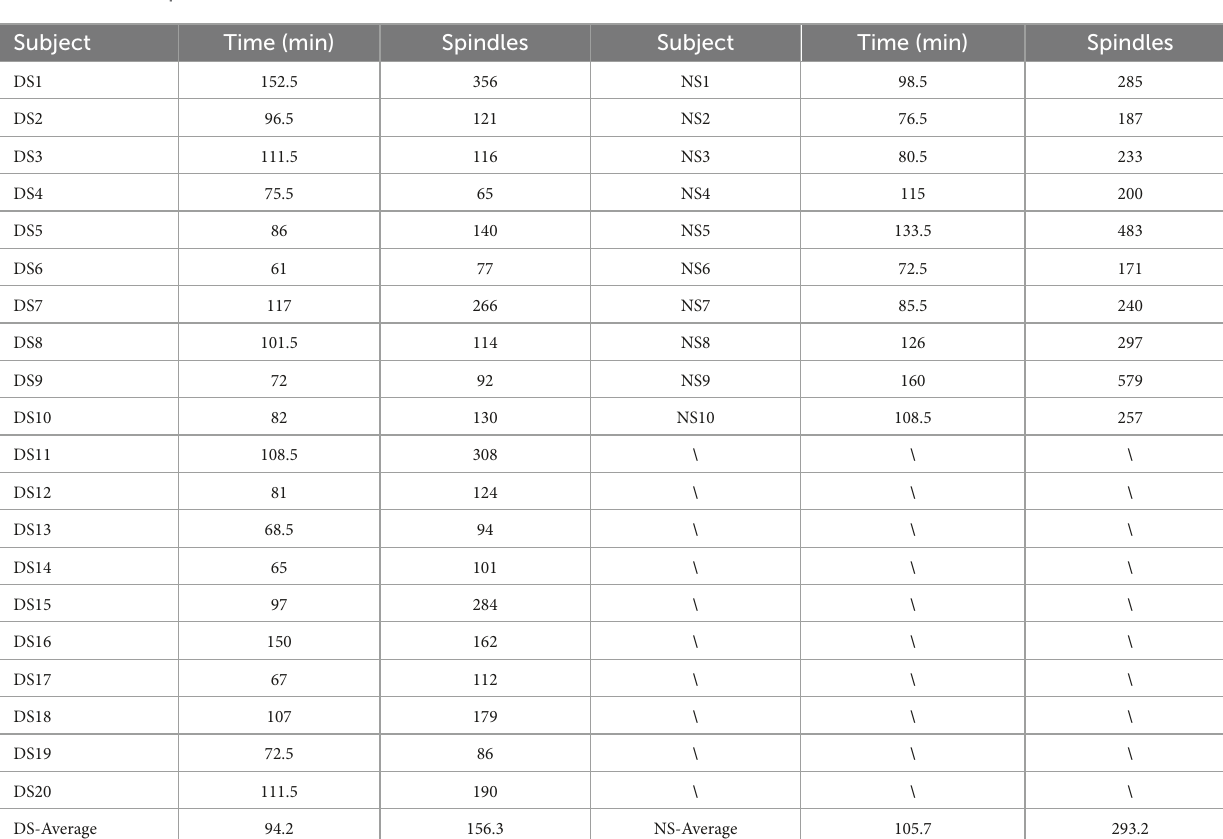
TABLE 2 Results of spindle wave number